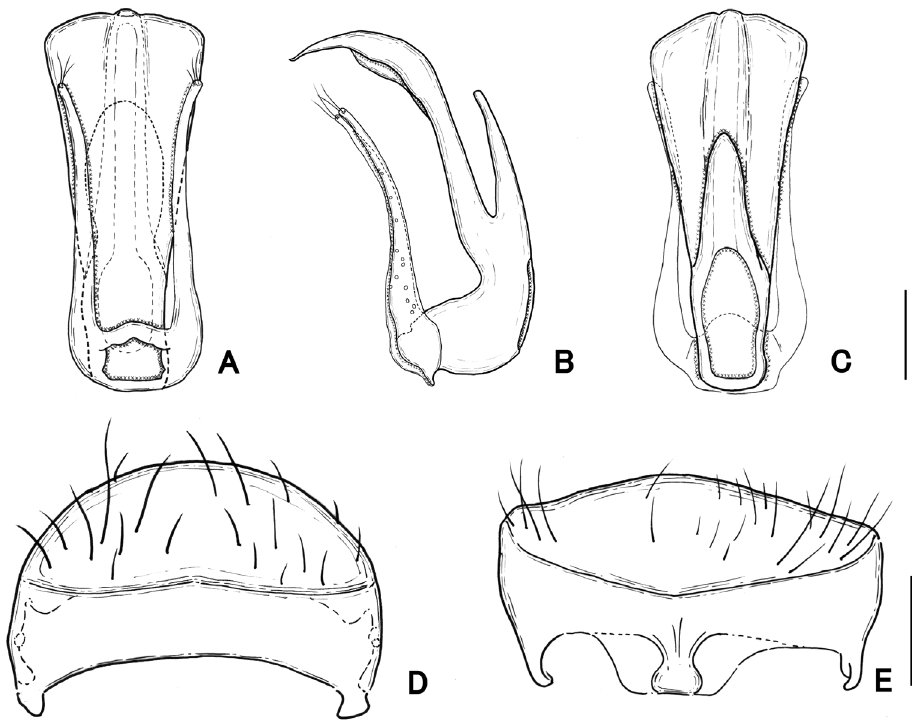
Figure 8. Male genitalia of Pseudophanias nakanoi A ventral view B lateral view C dorsal view D ter- gite VIII E sternite VIII. Scale bars: 0.1